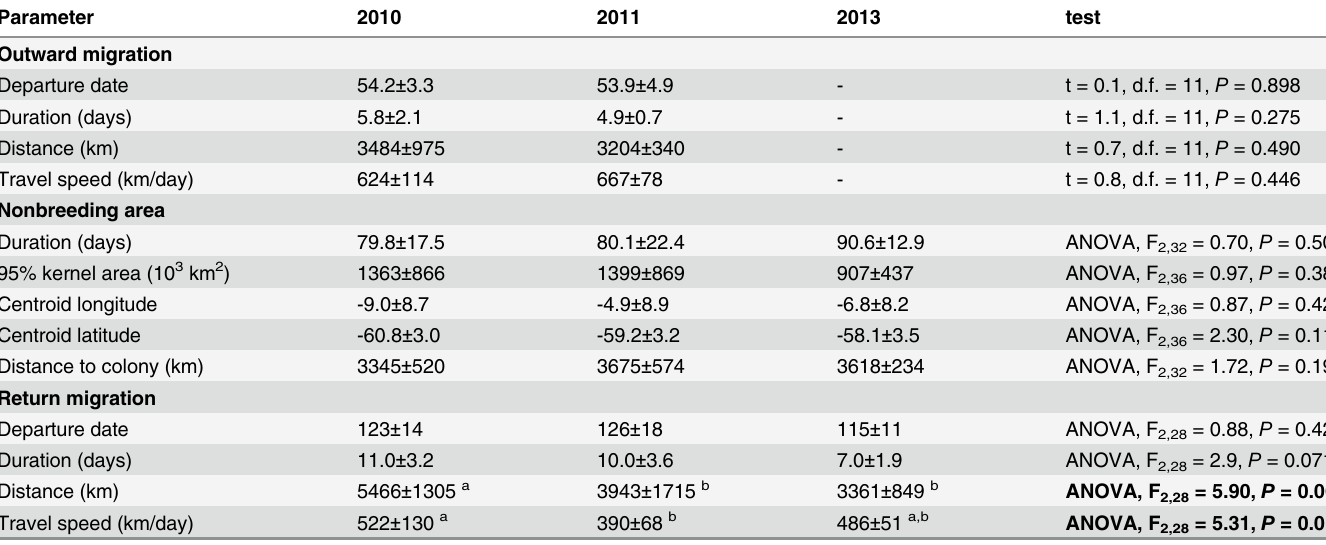
Table 4. Inter-annual comparison of the outward and return migration in thin-billed prions (means ± SD) from New Island, Falkland